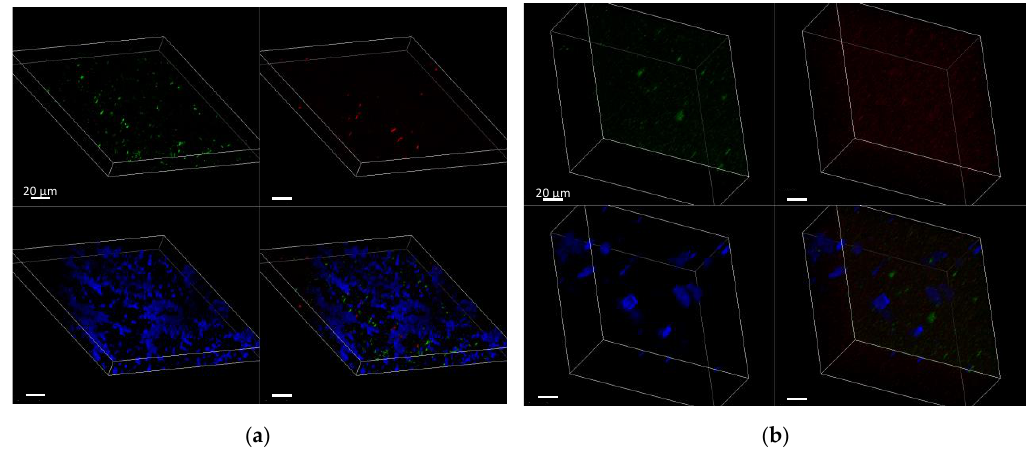
Figure 10. 3D reconstruction of biofilm after incubation of: ( a ) control SE sample and ( b ) SE sample treated with CS/ TA/AgNPs (2-Ag). Represented in green—tagged with SYTO9—are alive bacteria, in red—tagged with propidium iodide (PI)—are dead bacteria and in blue—tagged with Alexa 647—is the extracellular matrix (ECM). The scalebar corresponds to 20 µ m.